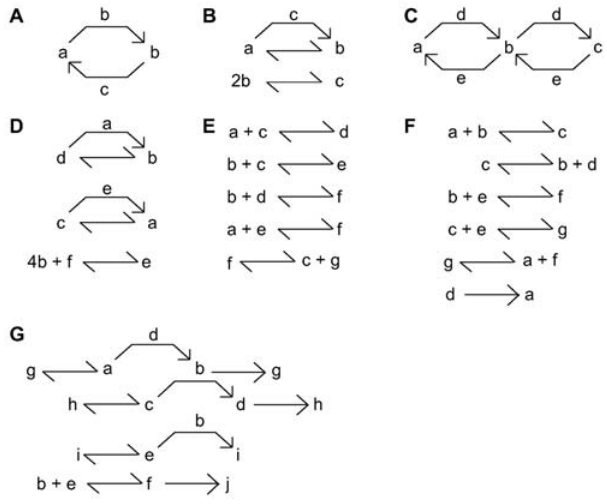
Figure 5. Known Bistables. (A,B) Published bistables from [20]. These are already present in our DAG. (C,D) Published bistables from [6] and [9]. These can be reduced to smaller models and have some bistable motifs from our dataset. (E,F) Bistables from [5]. (G) Bistable from [11]. None of (E), (F), and (G) had motifs from our dataset.